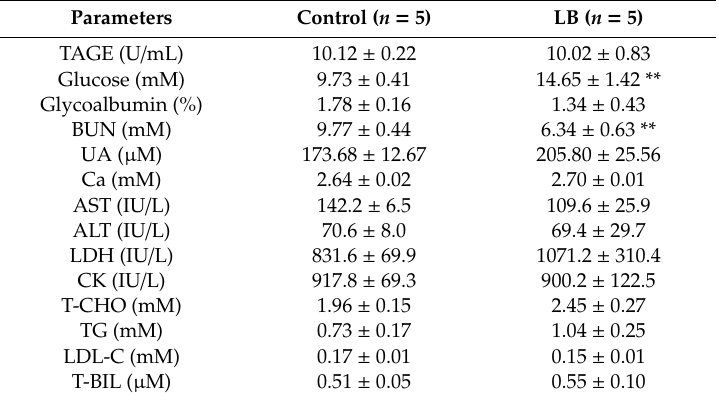
Table 5. Serum and plasma biochemistries in the Lactobacillus